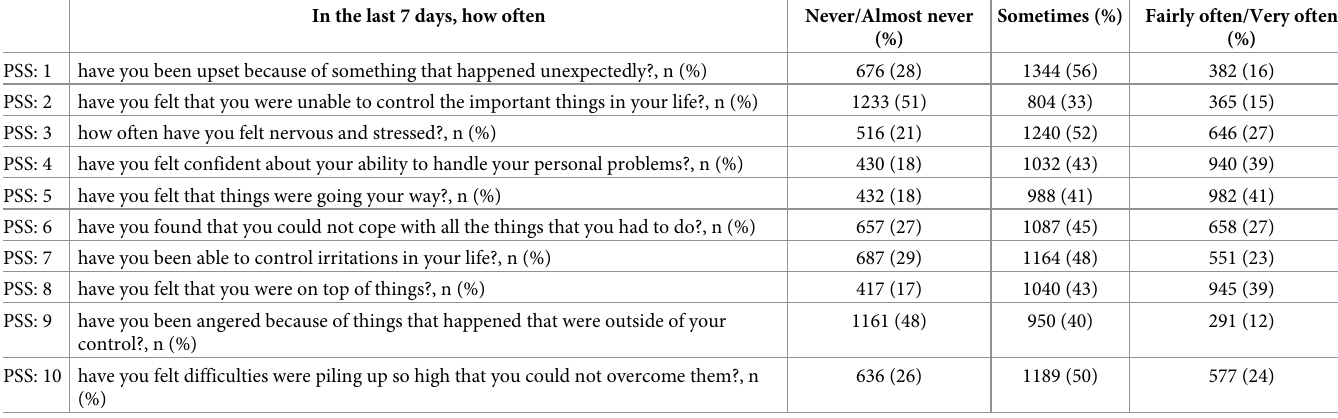
Table 3. Frequency of the statement related with perceived stress scale